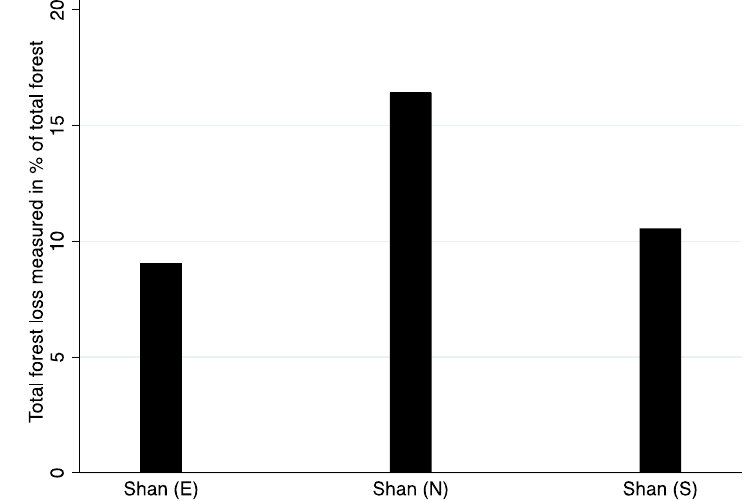
Figure 2. Total deforestation in parts of Shan State, 2000–2019.